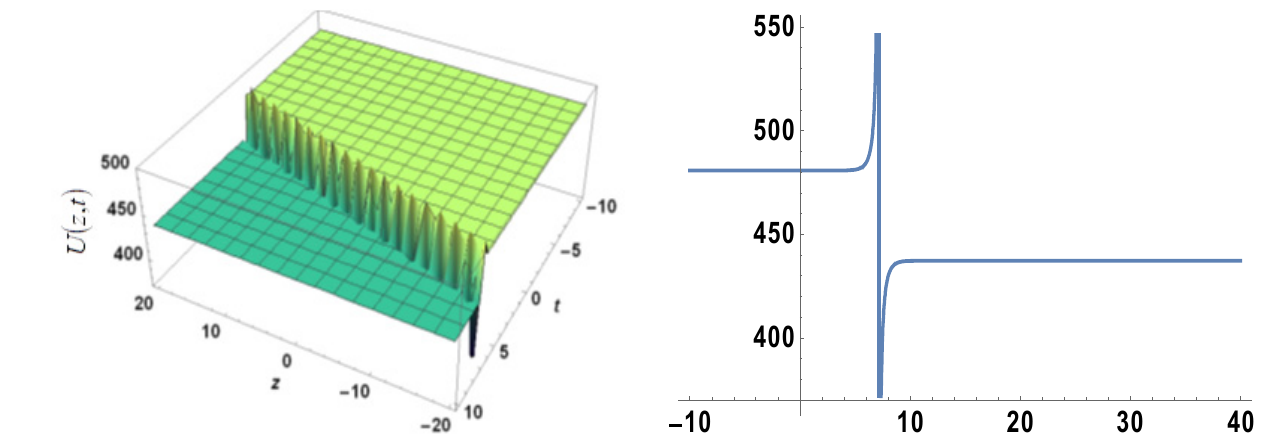
19 of 26 Figure 6. The 3D and 2D plots of Equation (56) for various values of parameters.